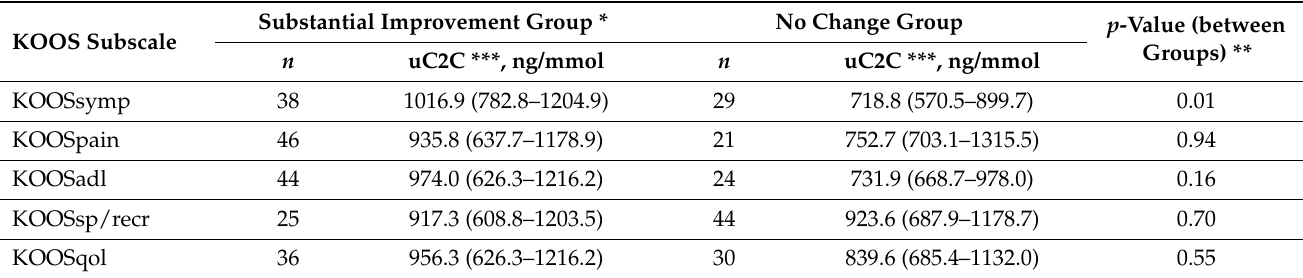
Table 4. Comparison of preoperative uC2C between SCB subgroups of KOOS subscales. KOOS